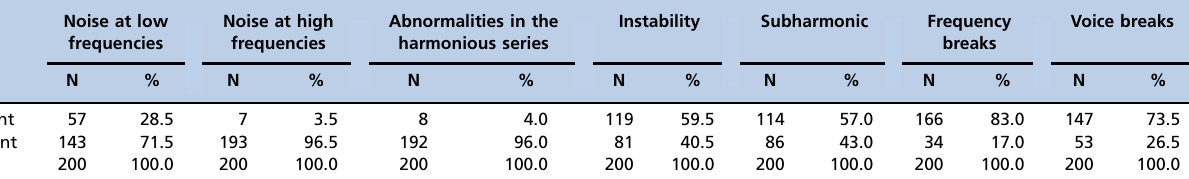
Table 2 - Distribution of categorical data related to APA and AA.